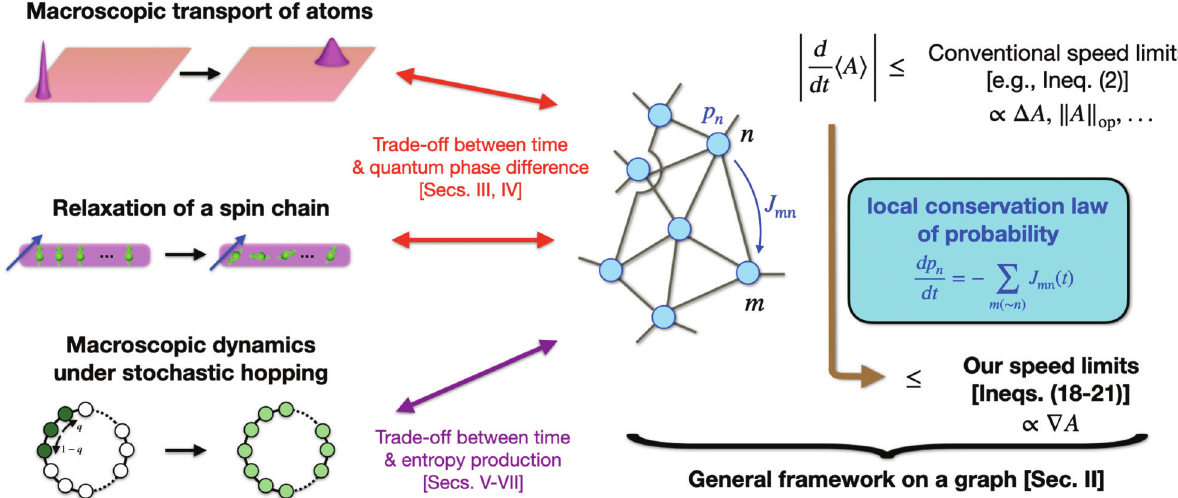
FIG. 1. Schematic illustration of our achievements. We establish a general framework for deriving qualitatively tighter speed lim- its of a quantity A than many conventional ones, which depend on the entire range of A , such as (cid:3) A or (cid:8) A (cid:8) op . Our strategy is to map general dynamics of our interest to dynamics on a graph, where we use the local conservation of probability. In contrast with conventional bounds, our speed limits involve the gradient ∇ A of A on the graph, which can significantly tighten the bound when ∇ A (cid:10) (cid:3) A or (cid:8) A (cid:8) op . When applied to macroscopic quantum systems (such as macroscopic transport of atoms or relaxation of a locally perturbed spin chain), our theory indicates a novel trade-off relation between time and the quantum phase difference. When applied to macroscopic stochastic dynamics, including the quantum one, our theory indicates a trade-off relation between time and quantities such as the entropy